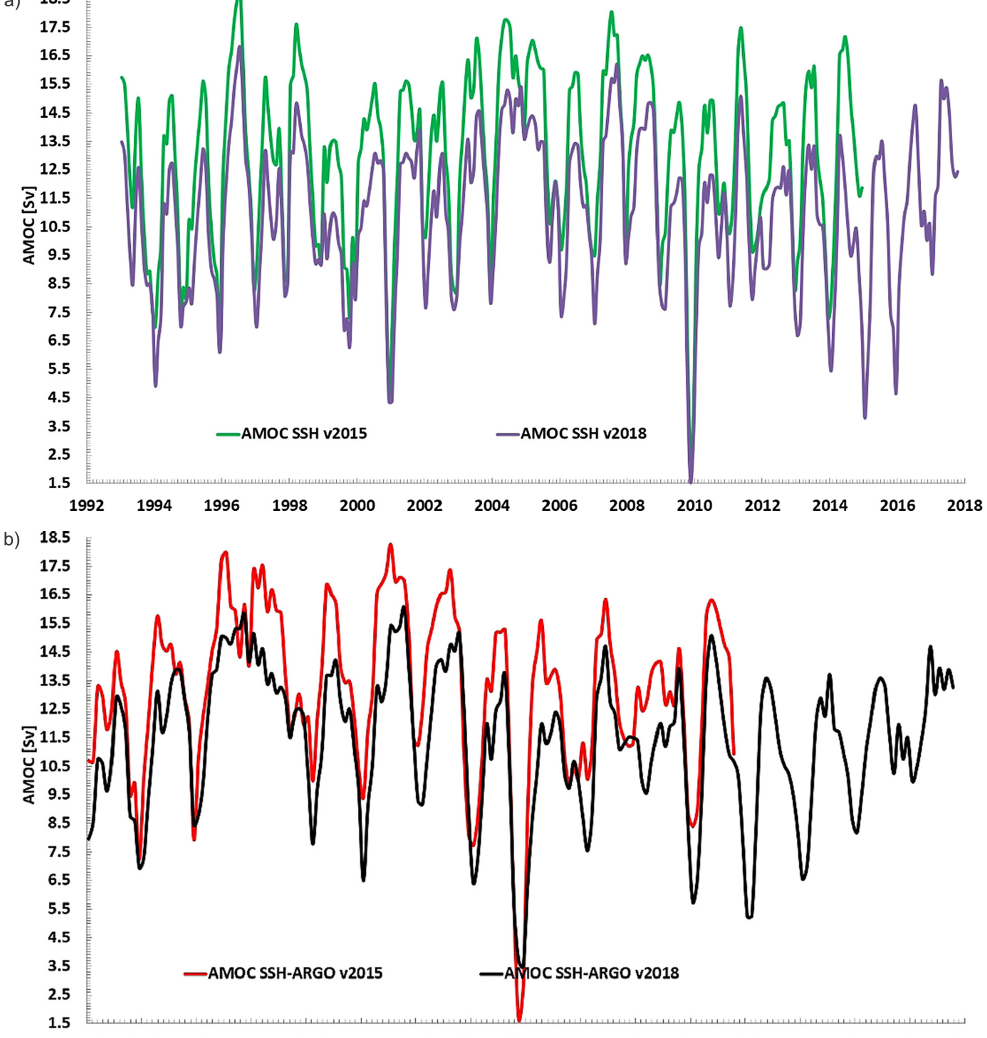
Fig. A.2.1. Comparison of the AMOC SSH (a) and AMOC SSH+ARGO (b) of 2015 and